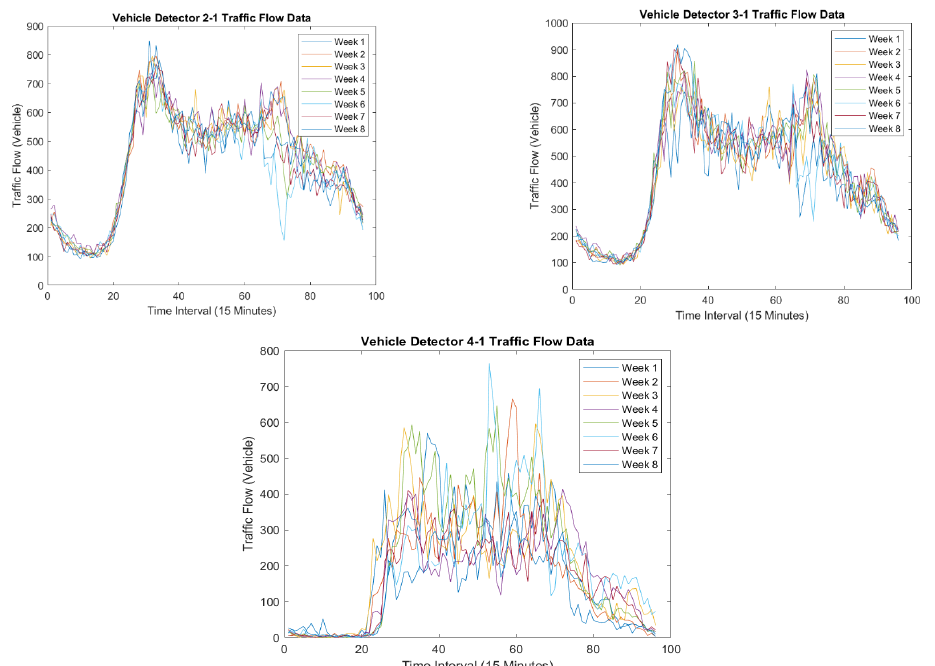
Figure 13. Plot of traffic count data of vehicle detector 4-1 for each week show huge fluctuation compared to other vehicle detectors in Diponegoro neighborhood. This vehicle detector shows a fluctuating pattern, which results in huge imputation error.